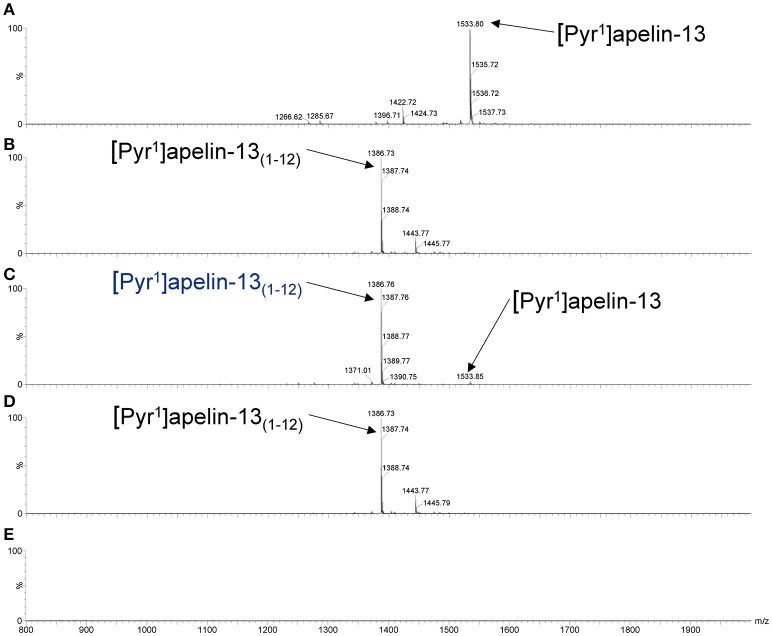
Cleavage of [Pyr1]apelin-13 to [Pyr1]apelin-13(1–12) by rhACE2 in vitro. Maldi-TOF spectra for (A) [Pyr1]apelin-13, (B) [Pyr1]apelin-13(1–12), (C) [Pyr1]apelin-13 incubated with rhACE2, (D) [Pyr1]apelin-13(1–12) incubated with rhACE2, (E) rhACE2 alone.